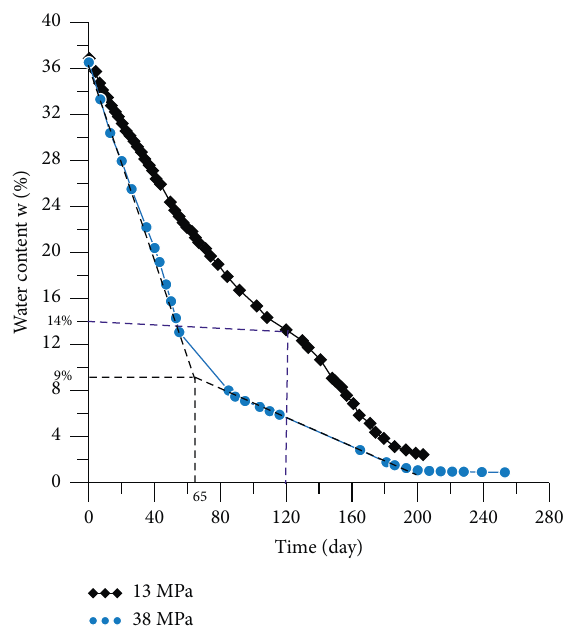
Figure 6: Experimental curve-water content versus time of kaolin clay.